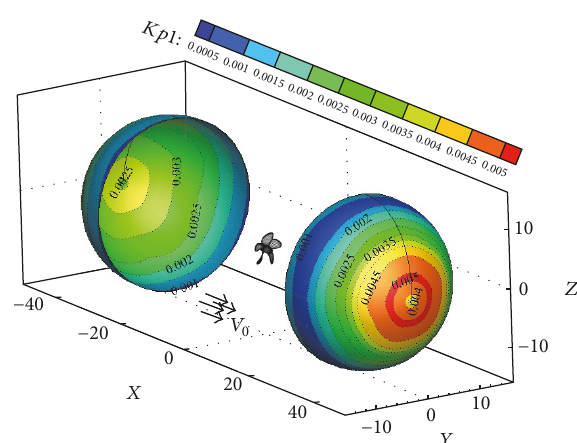
Figure 16: 3D contour of rear propeller